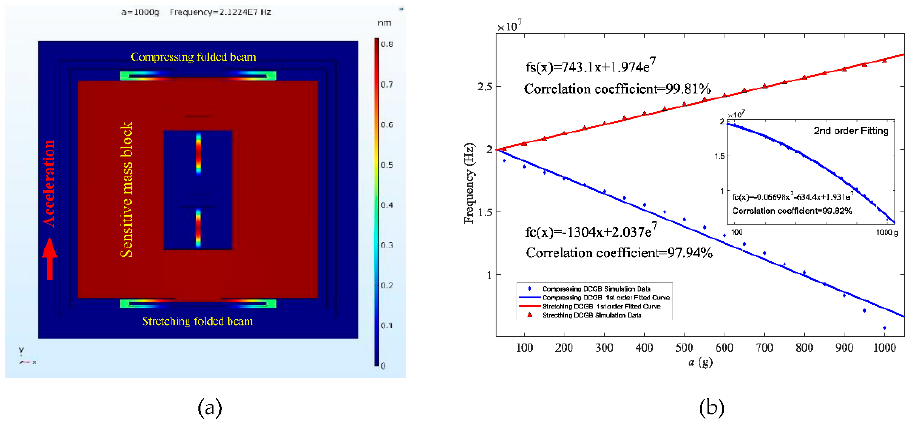
Figure 5. Simulation results of resonant accelerometer. ( a ) The displacement of sensitive proof mass of accelerometer under 1000 g acceleration; ( b ) resonance frequency variations of compressing and stretching DCGB as function of acceleration.